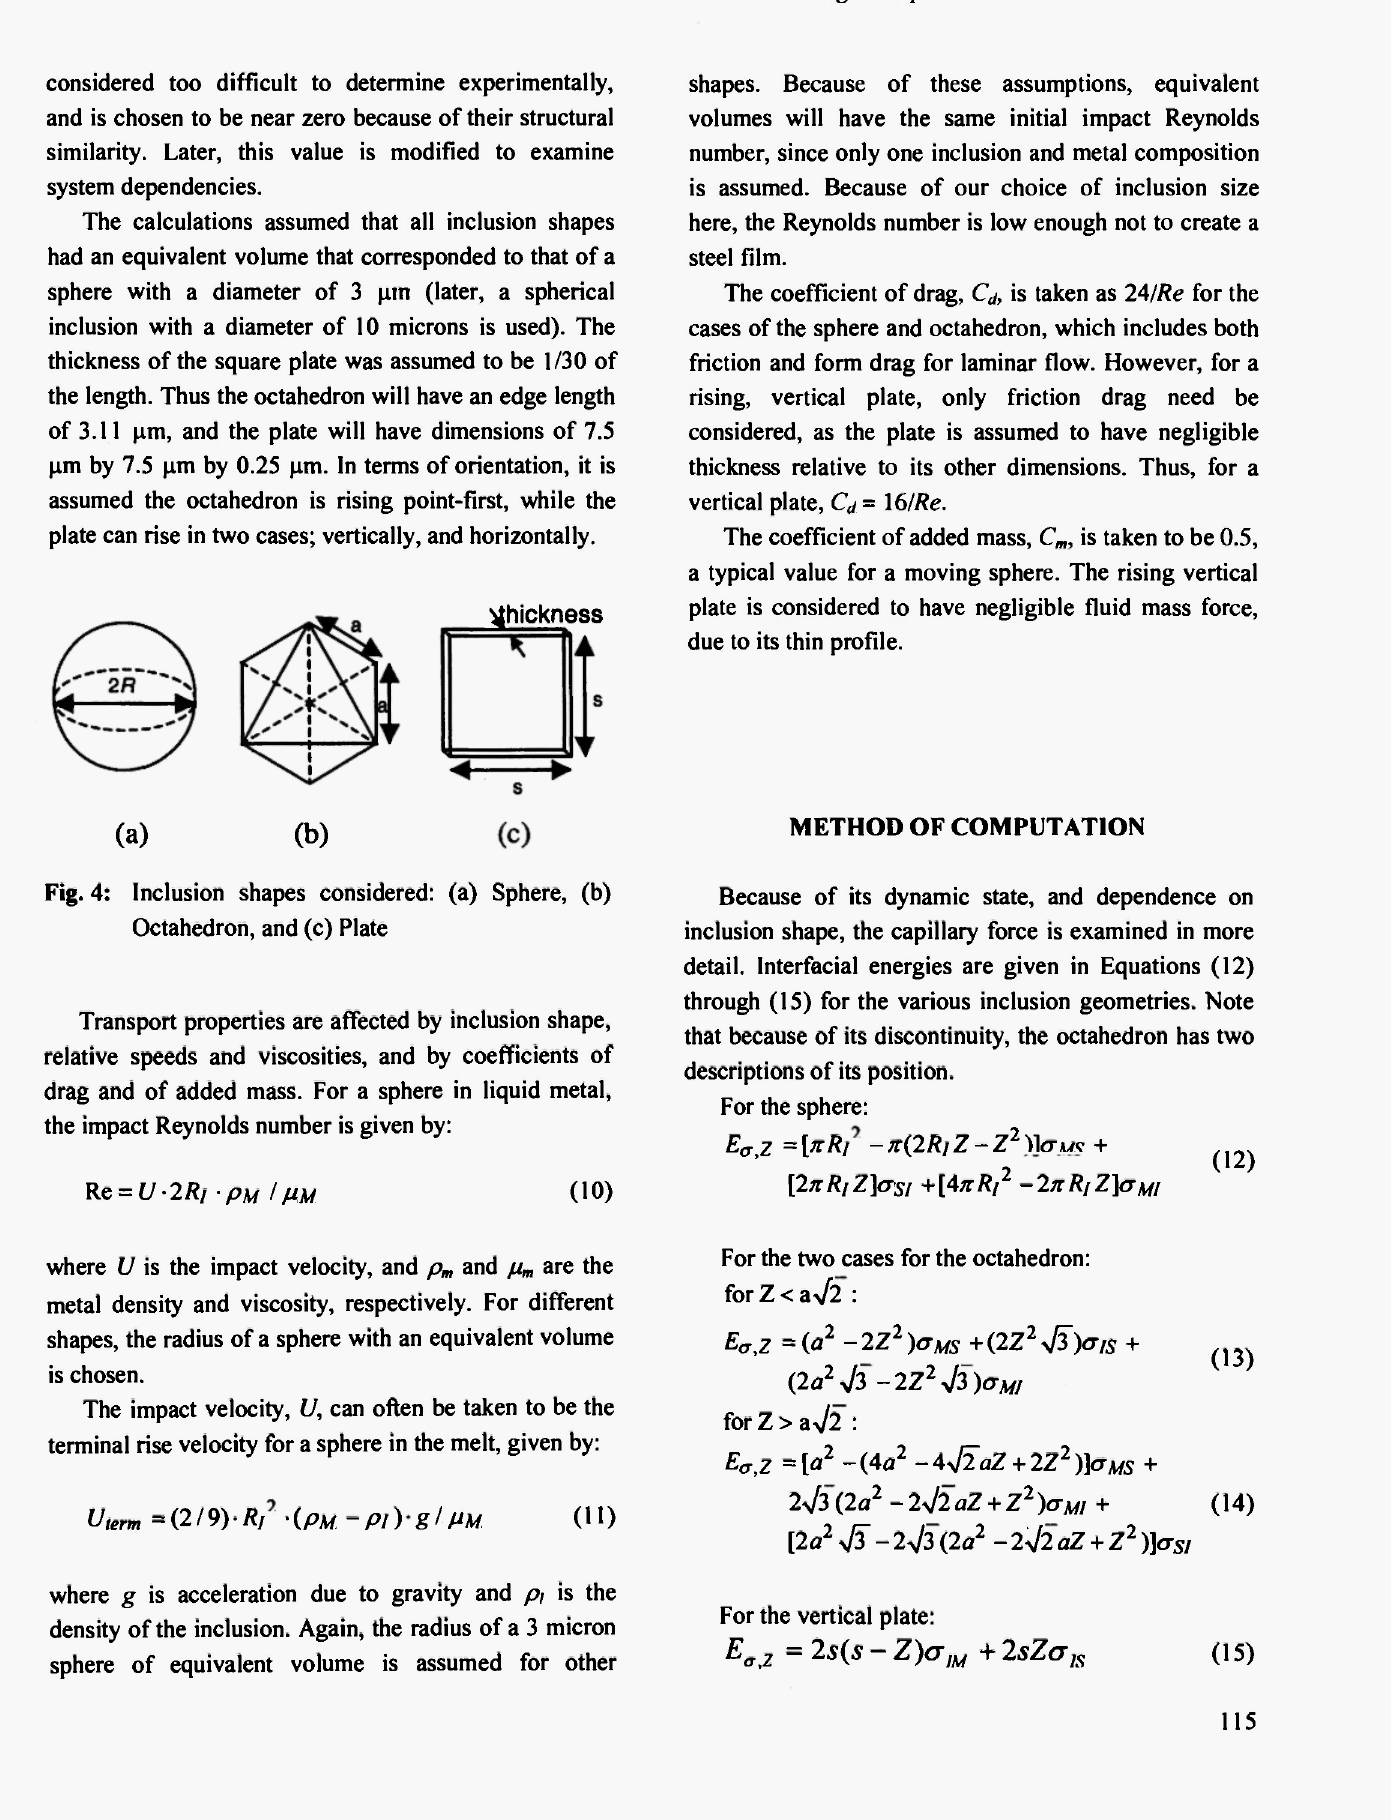
Fig. 4: Inclusion shapes considered: (a) Sphere, (b) Octahedron, and (c)